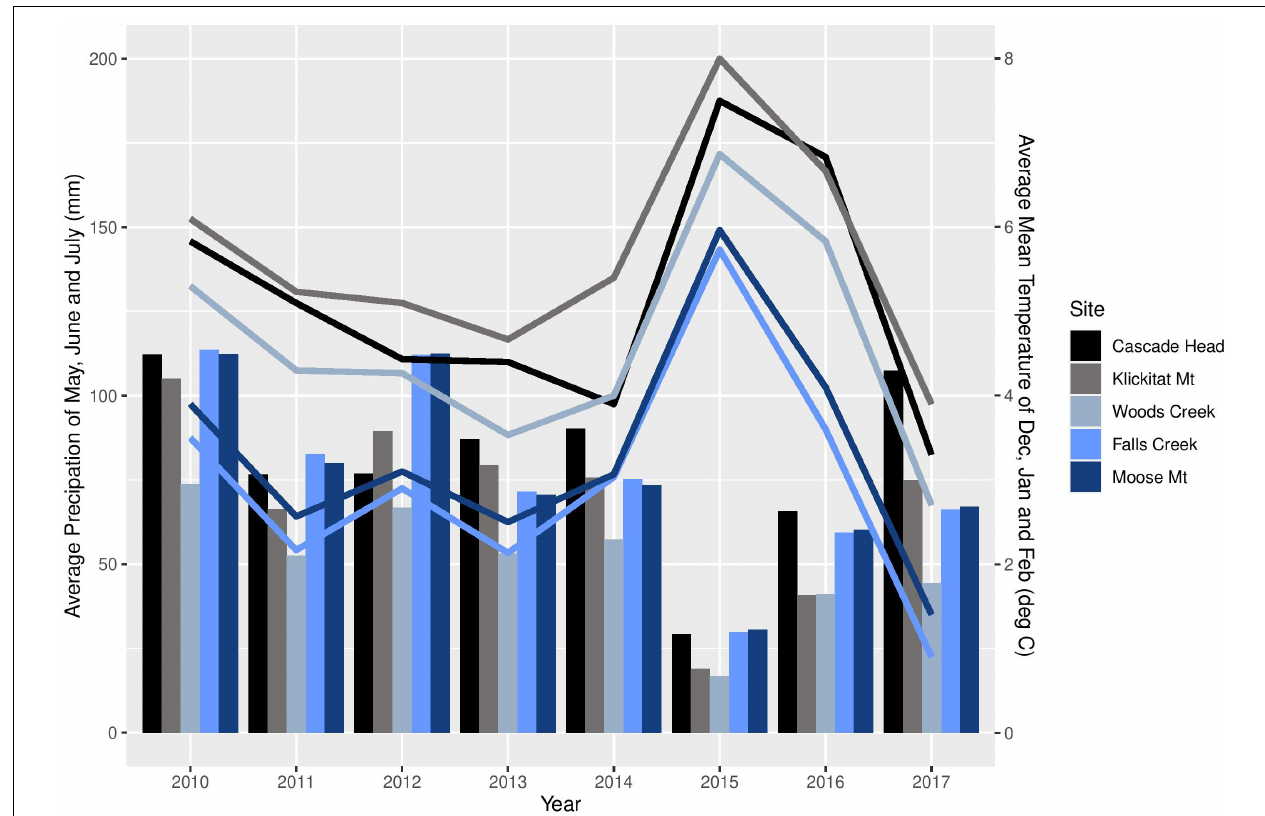
FIGURE 3 | Average winter (December, January, and February) mean temperature (lines) and average summer (May, June, and July) precipitation (bars) of each study site from 2010 to